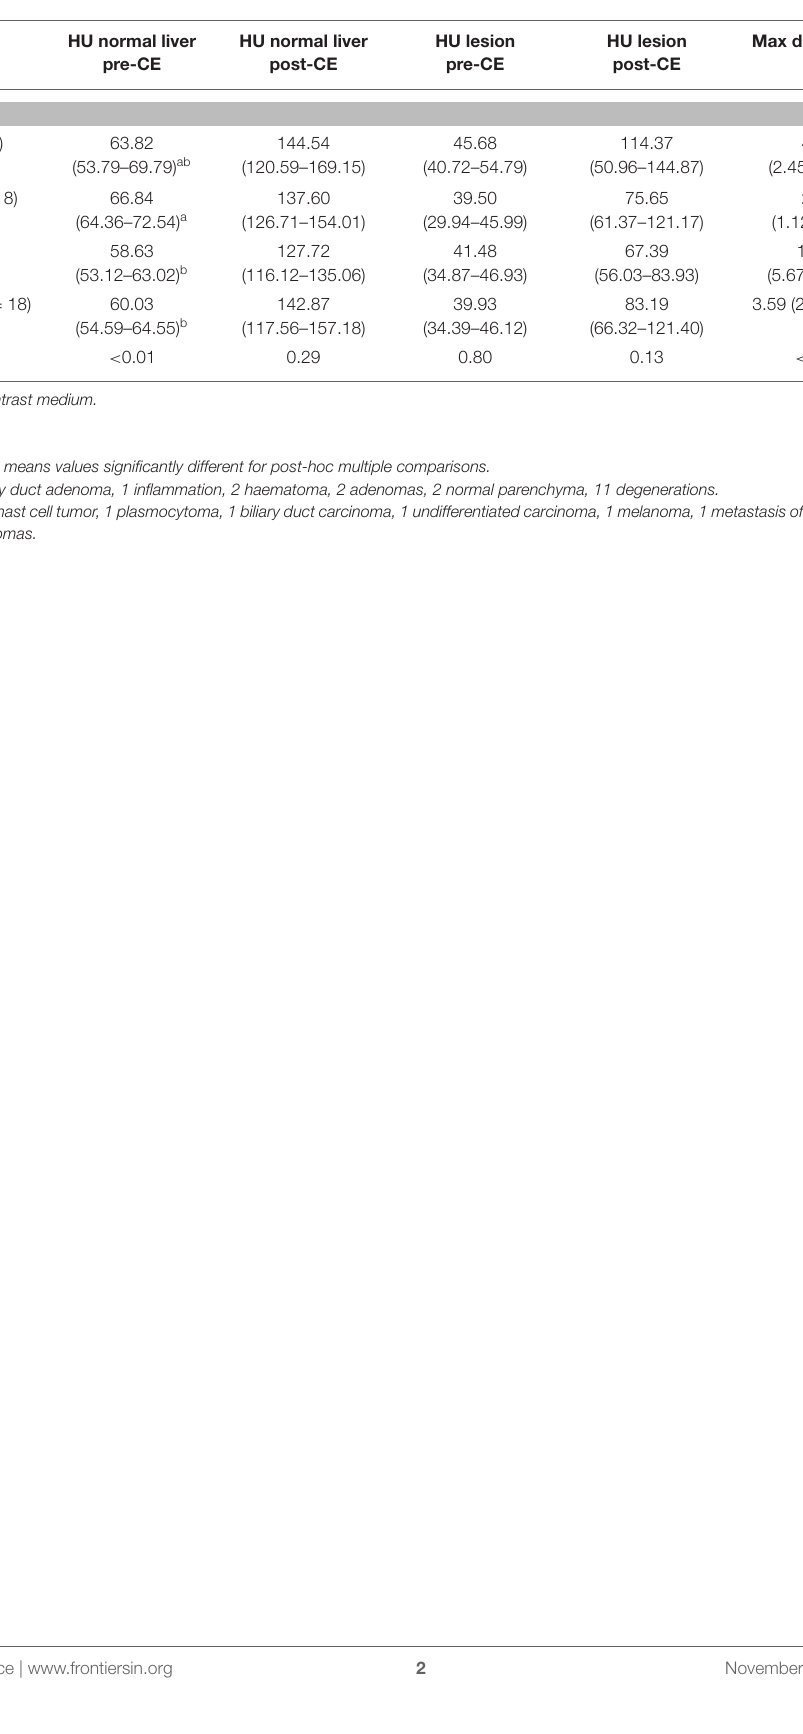
TABLE 2 | Quantitative features of the lesions, classified based on cytological or histological examination, are reported as medians along with the first and third quartile values and the p